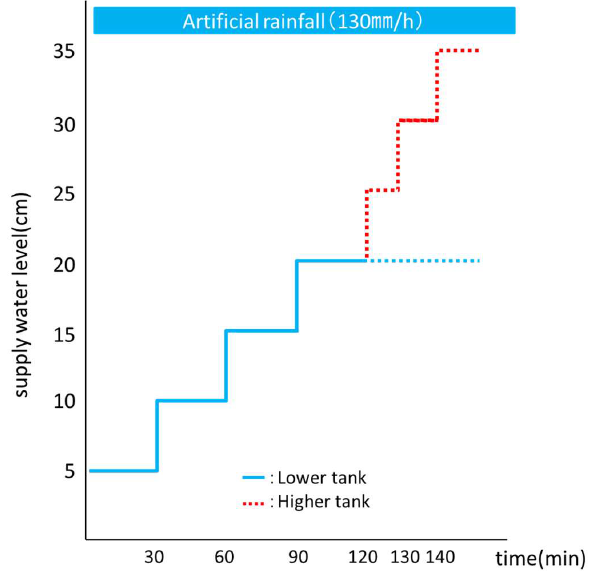
Figure 5. Water supply conditions. The water supply system supplied water in a manner consistent with artificial rainfall simulators. Artificial rainfall simulators can supply water at a rate of 130 mm/h. We increased the water level by 5 cm every 30 min until 20 cm, 5 cm every 10 min beyond 20 cm. We used the lower tank and higher tank until the water level reached 20 cm, then the higher tank as the water level increased beyond 25 cm.